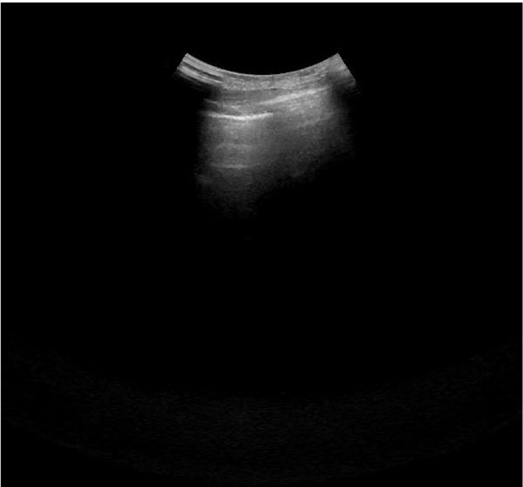
Figure A1. A-lines (Normal)—score 0. J. Clin. Med. 2022 , 11 , x FOR PEER REVIEW